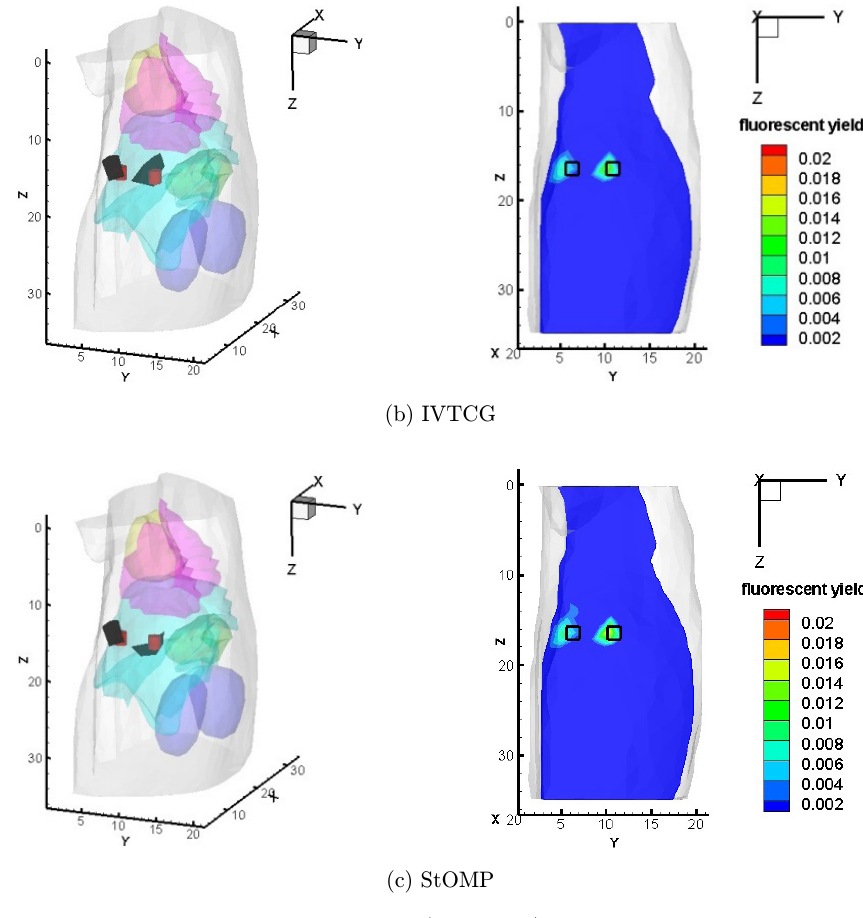
Table 4. Impact of Poisson noise on the proposed method.